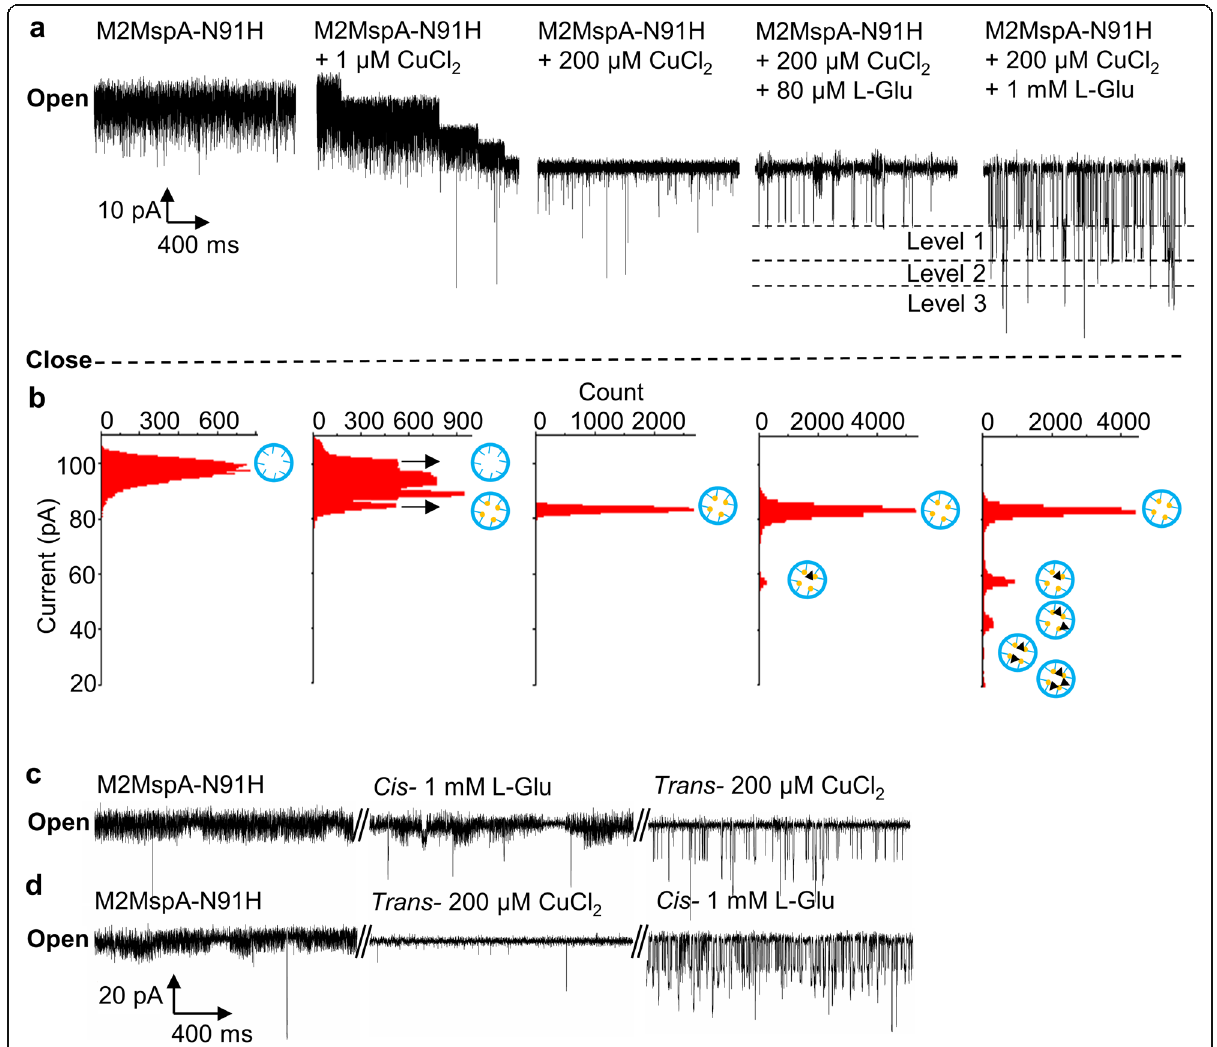
Fig. 2 Binding of Cu 2+ to M2MspA-N91H and L-Glu detection. a . Representative single-channel current traces of M2MspA-N91H open pore baseline, the addition of 1 μ M CuCl 2 , 200 μ M CuCl 2 to trans chamber as well as the addition of 80 μ M, 1 mM L-Glu to cis chamber. b All points current histogram distribution of A, the cartoon insets illustrate the possible binding numbers and positions of Cu 2+ and L-Glu. Blue hollow circles represent M2MspA-N91H, yellow solid circles represent Cu 2+ , black solid triangles represent L-Glu. c,d Representative single-channel current traces of M2MspA-N91H open pore, 1 mM L-Glu and 200 μ M CuCl 2 , showing different signal changes generated by adding 1 mM L-Glu and 200 μ M CuCl 2 to trans chamber in a different order. (1 M KCl, pH 7.5, 298 K, + 50 mV). All the experiments were repeated at least 3